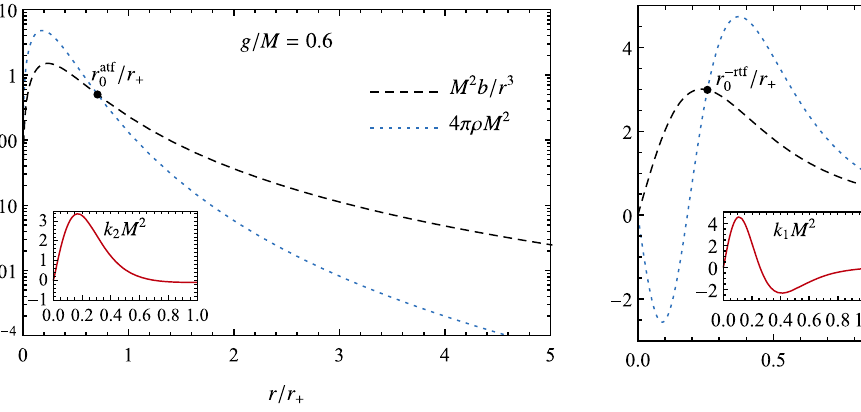
Fig. 4 Tidaltensorcomponent k 2 ,plottedintheinset,andtheseparated contributions to it, one from the energy density ρ (blue dotted line, dirtiness term) and the other from the Misner–Sharp energy b ( r ) (black dashed line) to the angular tidal forces, for Bardeen-like BHs ( ν = 2) with γ = 4